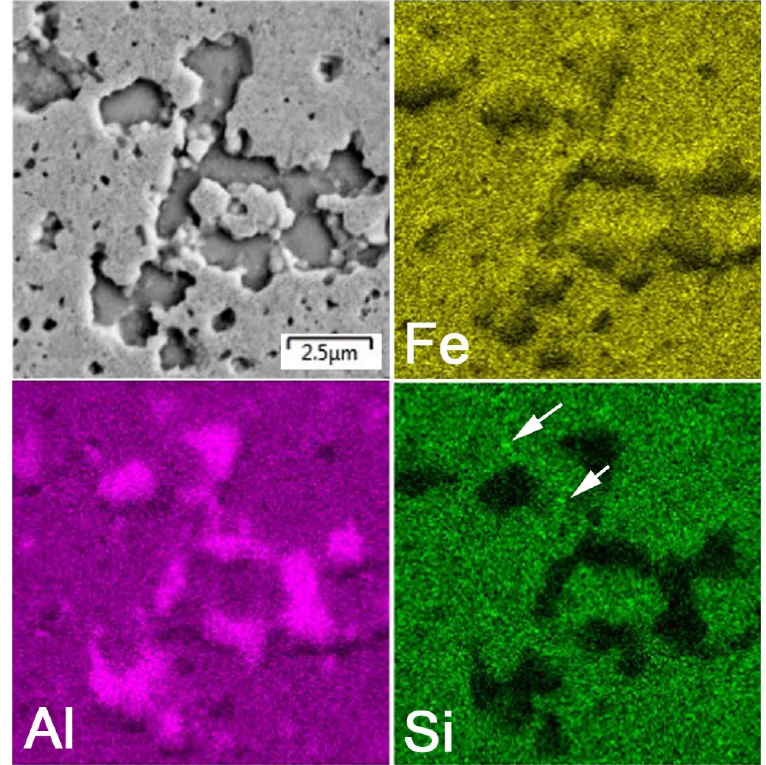
Figure 3. Energy dispersive spectrometer (EDS) elemental map of the bulk FeAl35Si5 alloy.